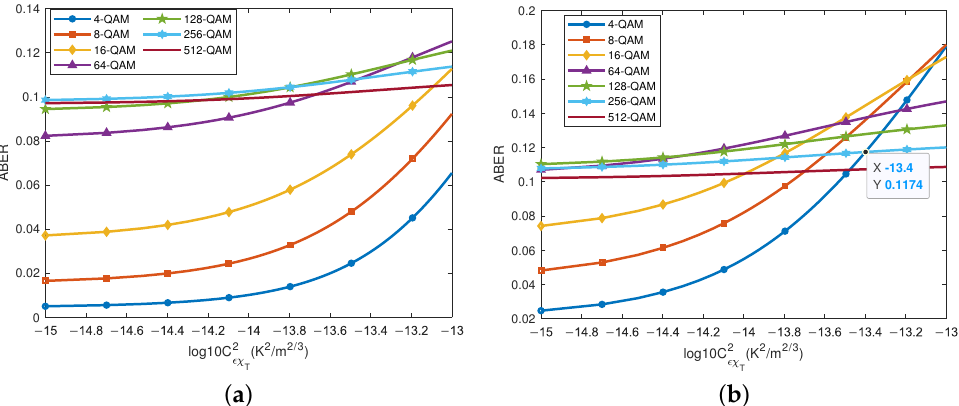
Figure 5. The bandwidth-limited ABER of POV carrier link with M-QAM versus turbulence strength in the link length of ( a ) z = 100 m, ( b ) z = 150 m.